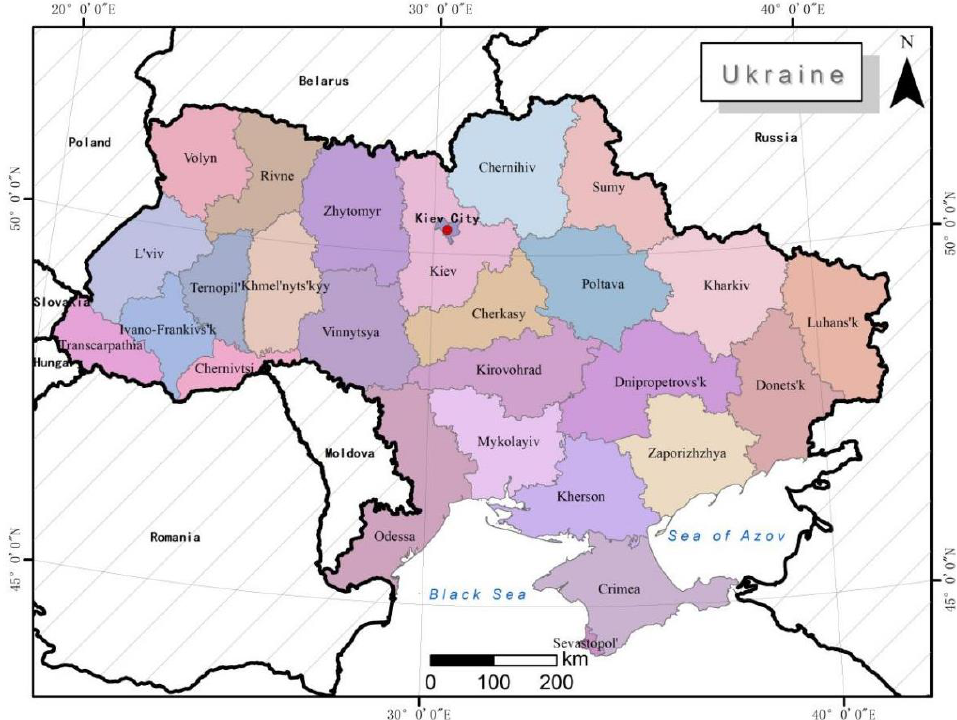
Figure 1. Map of Ukraine’s geographic